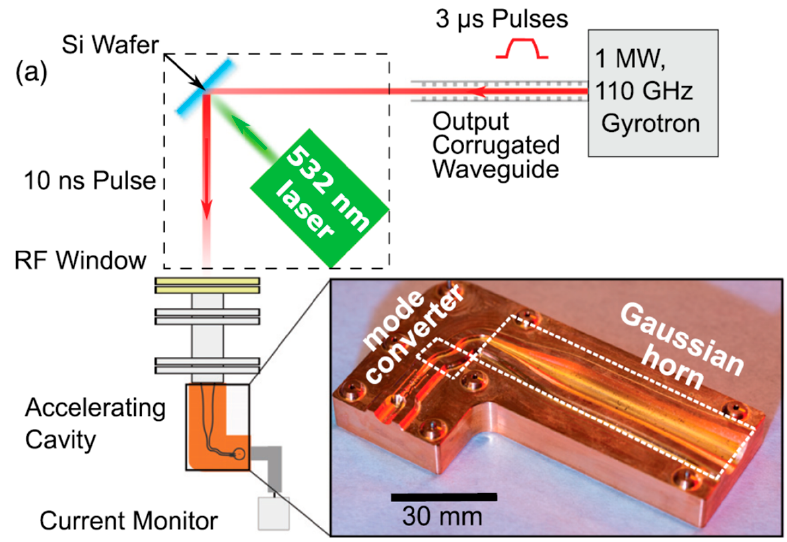
Figure 6. High-gradient mm-wave accelerating cavity test setup. Reprinted with permission from Ref. [59]. Copyright 2020 American Institute of Physics.